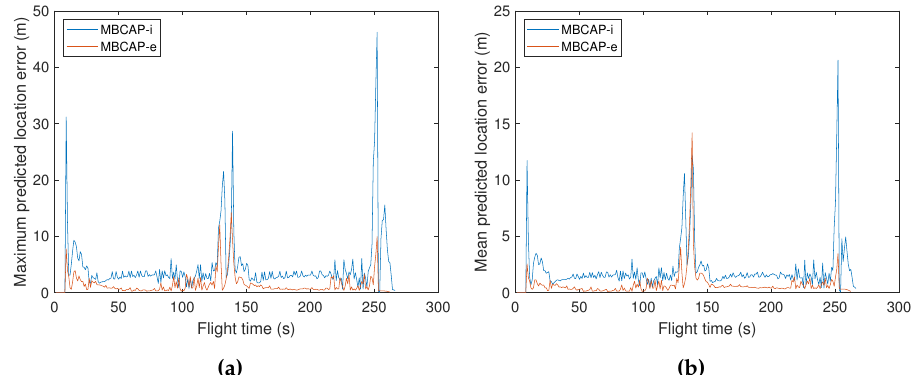
Figure 7. MBCAP-i vs. MBCAP-e: Predicted location error vs. flight time. ( a ) Maximum predicted location error. ( b ) Average predicted location